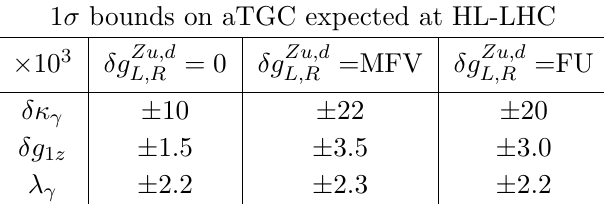
Table 7 . Constraints ( (cid:2) 10 3 ) on the anomalous triple gauge couplings using the projections at HL-LHC of the pp ! W + W (cid:0) ! ‘(cid:23)‘(cid:23) channel. The (cid:12)rst column corresponds to the traditional diboson analysis that considers only aTGCs and sets to zero all anomalous fermion-gauge vertices (cid:14)V (cid:22) qq = 0. The next two columns show the e(cid:11)ect of letting these anomalou fermion-gauge vertices (cid:13)oat, assuming either a MFV or a FU setup